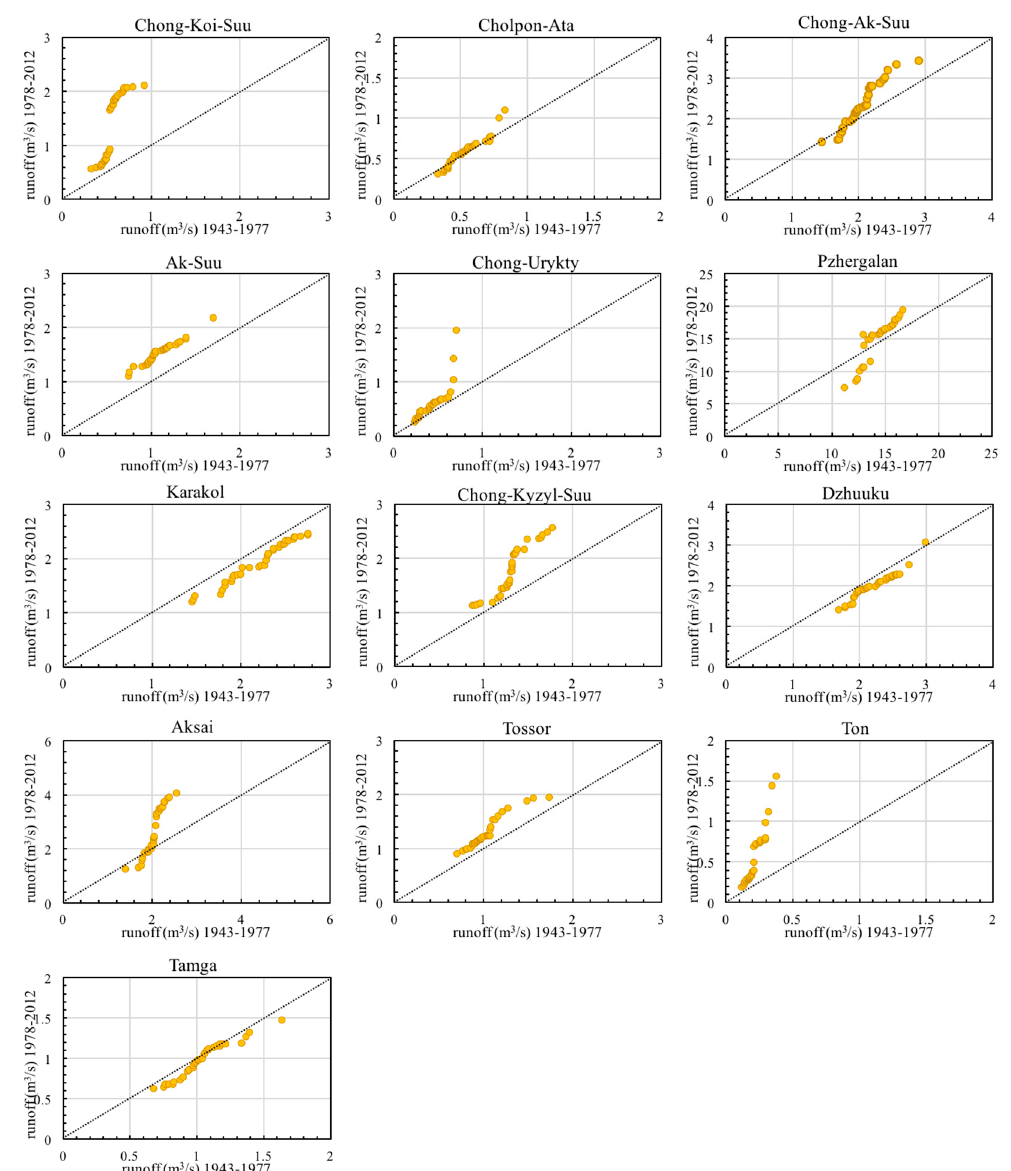
Figure 7. Analysis of the ITA for winter river runoff at 13 . Table 4. Analysis of ITA (slope s) of seasonal river runoff (1943–2012) .